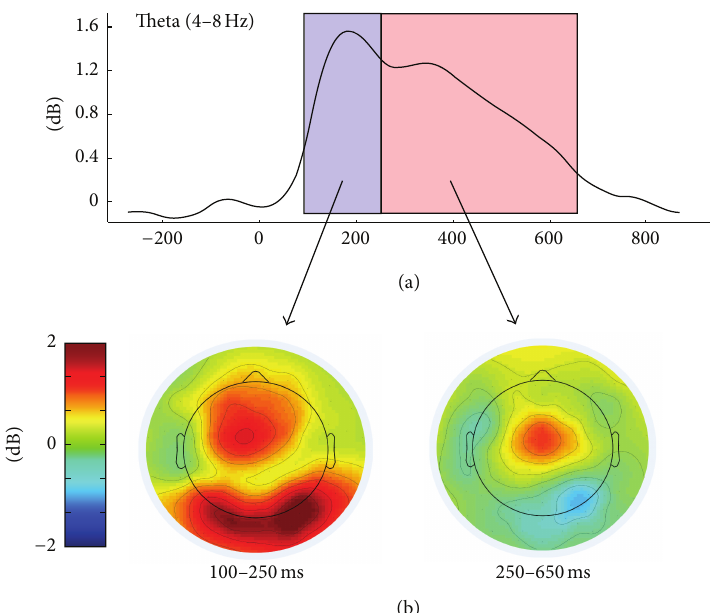
Figure 1: (a) Plot showing the grand average of theta power (in dB) across time. (b) The topo plots for theta power are shown for the early (left) and later peak